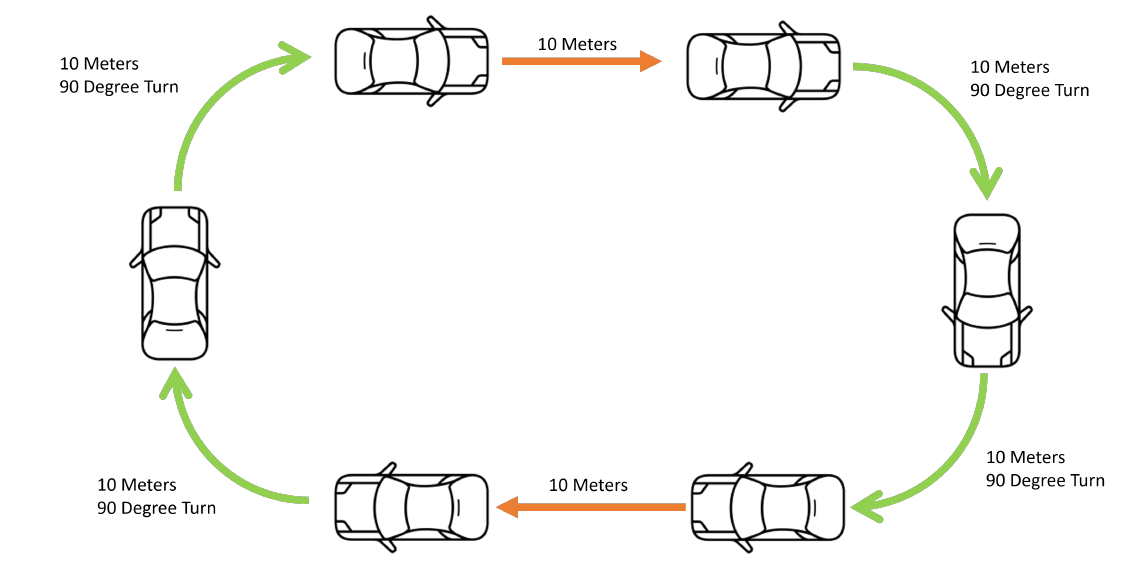
Figure 8. Figure showing the perfect closed-loop system.